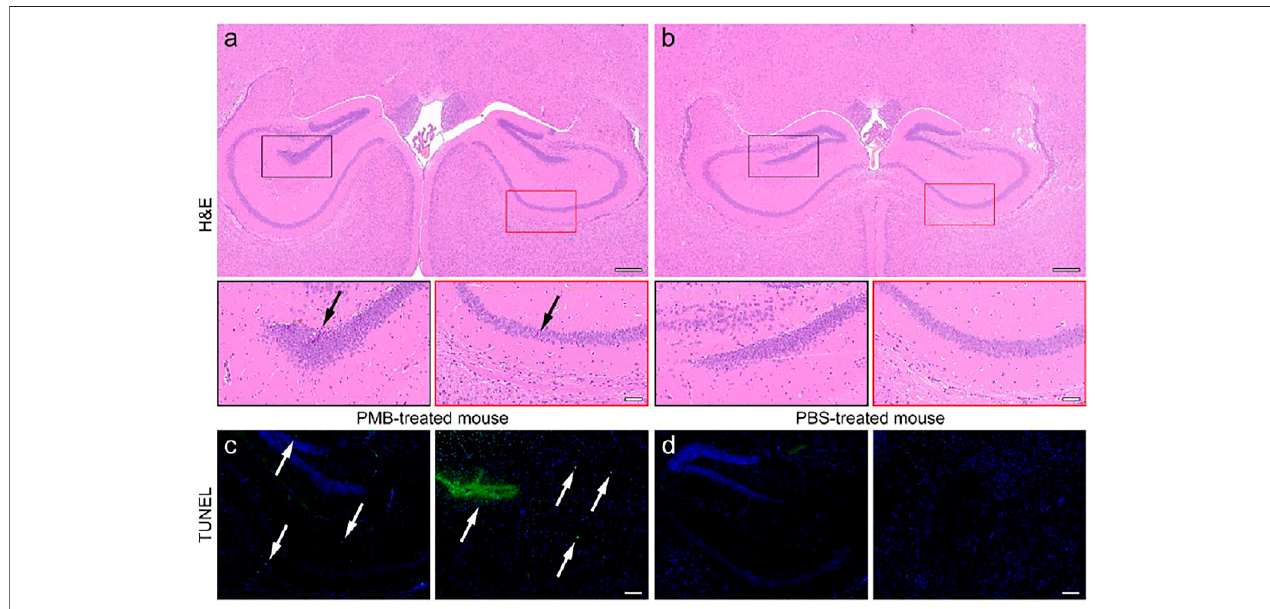
FIGURE 4 | H&E staining of the brain slices of (a) PMB-treated mouse and (b) PBS-treated mouse, in which the DG and CA1 region in black and red frames are enlargedinthebottom,respectively.TUNELstainingofthebrainslicesof (a) PMB-treatedmouseand (b) PBS-treatedmouse,wherethepositivesitesarehighlightedby white arrows. The embedded scale bar in the top, the bottom of (a,b) , and (c,d) corresponds to 100, 50, and 100 μ m,